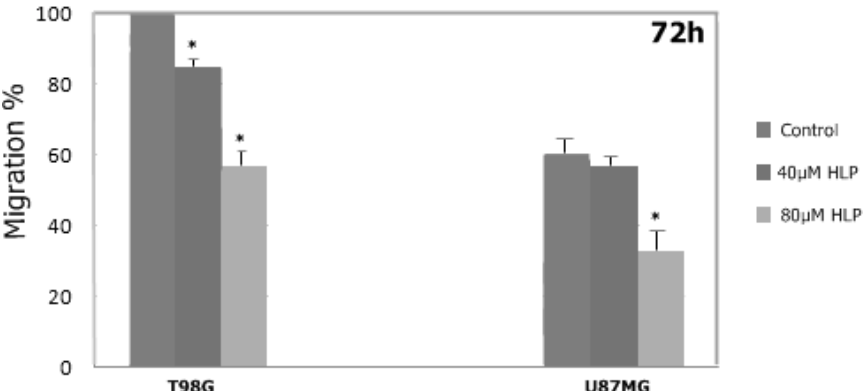
Figure 6. The influence of haloperidol (HLP) on the migratory ability of glioblastoma cells T98 and U87 at 72 h (quantified). Width migration = Width 0h − Width 72h The experiment was performed in triplicate. Values expressed as migration percentages, and the wound widths at 0 h were set as 0%. Significant di ff erences ( p < 0.05) were marked with an asterisk.